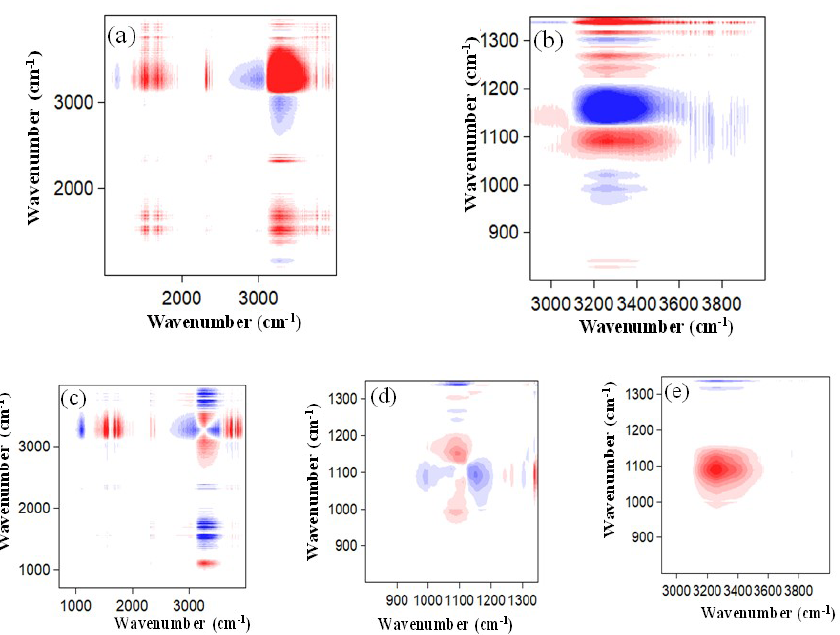
Figure 8. The same as Fig. 7 but for AS / SN mixed nanoparticles. Panel (b) is an enlarged view of (a) , and (d) and (e) are enlarged views of (c) within different wavenumber regions.